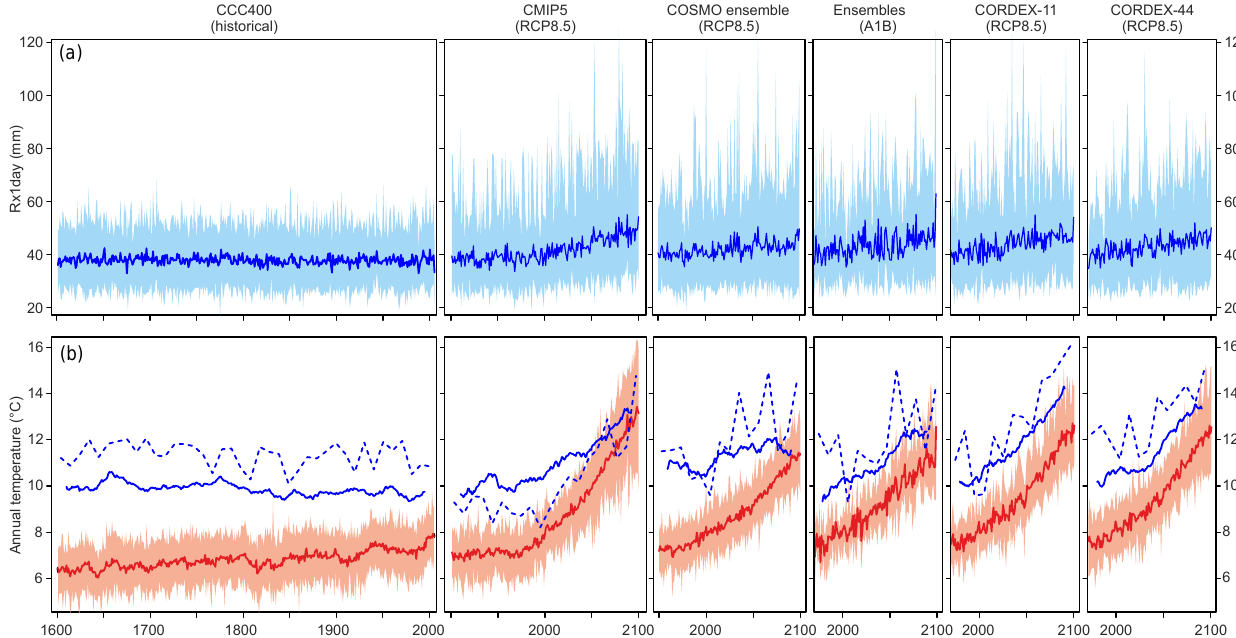
Figure 2. Annual time series (ensemble mean as line and ensemble range as shading) of (a) Rx1day and (b) annual mean temperature (red) as well as the temperature during the Rx1day event (blue solid line, smoothed with a 20-year running average) in CCC400, CMIP5, and COSMO (quantile mapped). Also shown is the temperature at the highest Rx1day event per decade (blue dashed; ensemble mean).